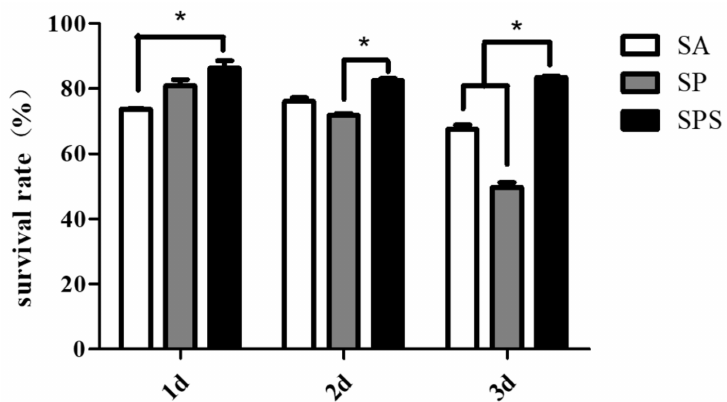
Figure 8. Inhibition rate of the SPS, SP and SA hydrogel spheres on the L929 cells (* p < 0.05, mean ± SD, n = 3).